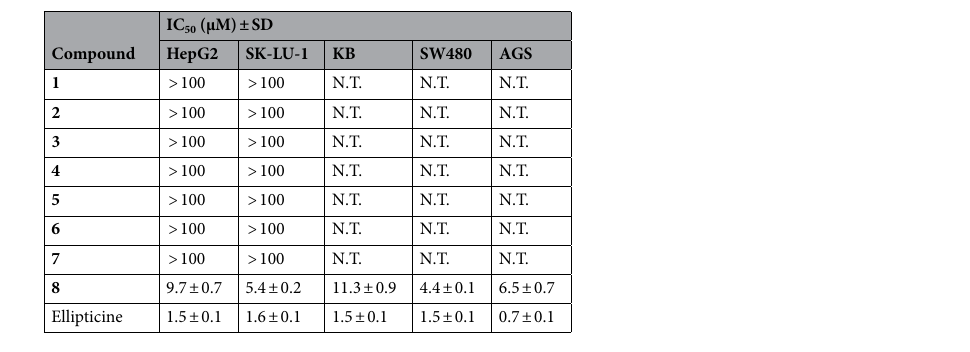
Table 2. Cytotoxicity of the compounds 1 – 8 isolated from Z. ajax Hort. and ellipticine (as a positive control). N.T. the compounds were not